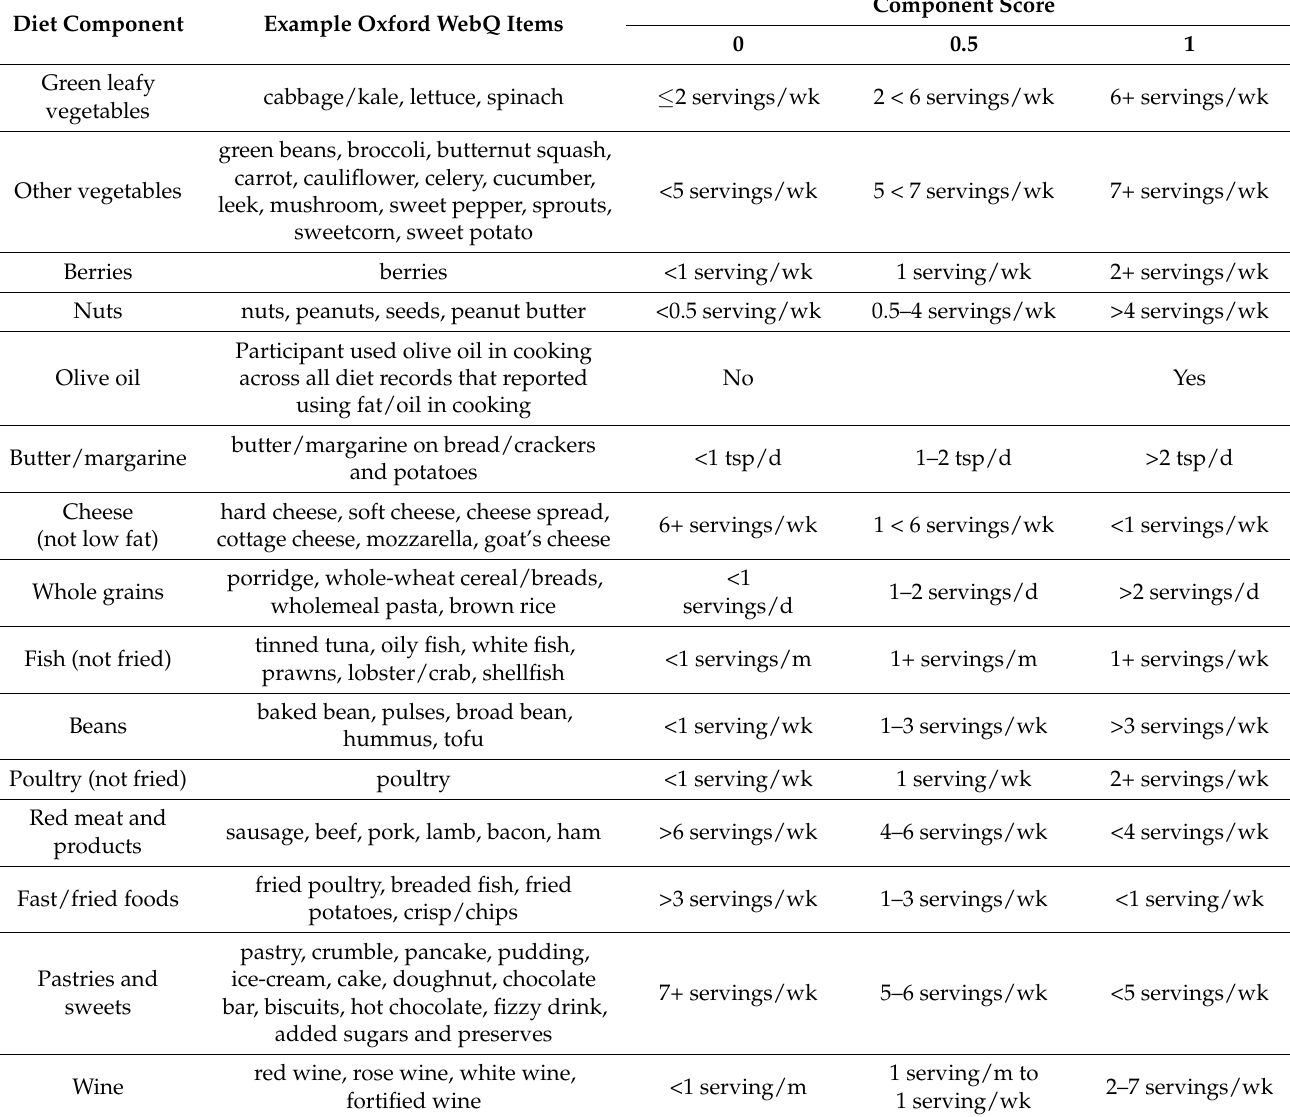
Table 1. MIND adherence score in the UK Biobank 1